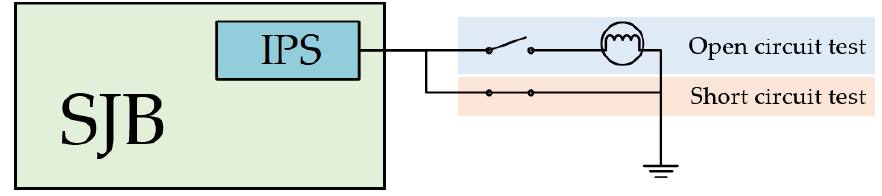
Figure 18. Protective operation and diagnosis test environment.